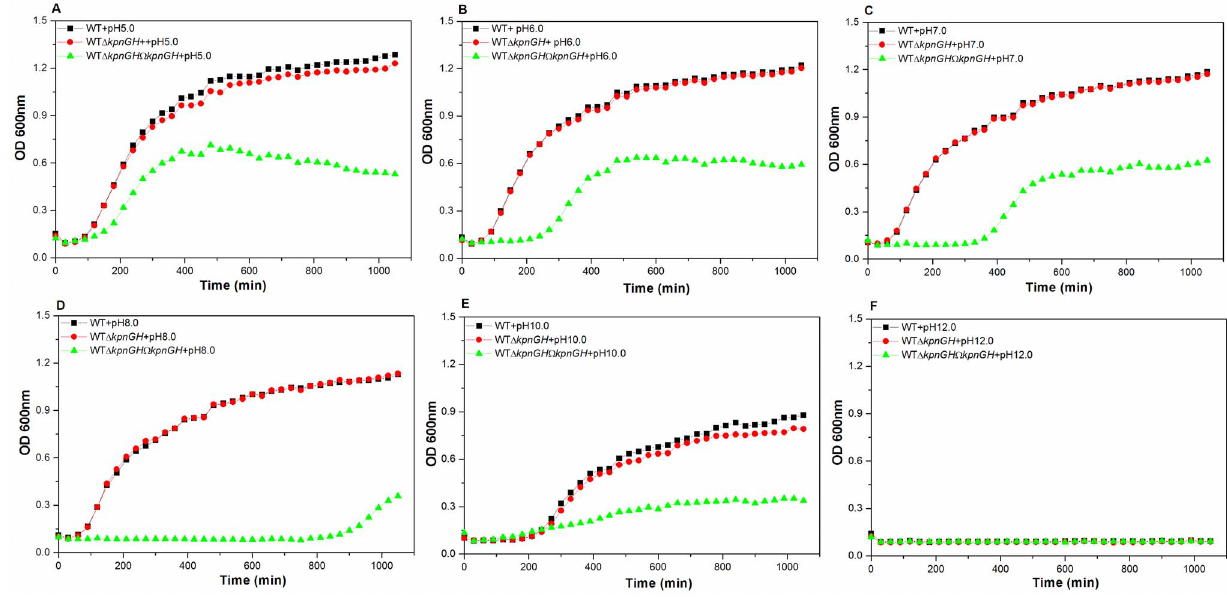
Figure 1. Growth kinetics. Effect on bacterial growth was monitored in WT, D kpnGH and D kpnGH V kpnGH in LB medium at pH 5.0, 6.0, 7.0, 8.0, 10.0 and 12.0. The patterns of representative pH (5.0 (A), 6.0 (B), 7.0 (C), 8.0 (D), 10.0 (E), 12.0 (F)) are shown here. The mutant exhibited 1.782 fold ( 6 0.0002), 2.466 fold ( 6 0.00047), 3.22 fold ( 6 0.000011), 8.46 fold ( 6 0.00058), 1.909 fold ( 6 0.00032), reduced growth compared to WT strain in LB at pH 5.0, 6.0, 7.0, 8.0, and 10.0 respectively. The data presented is the means of triplicate measurements performed three times.